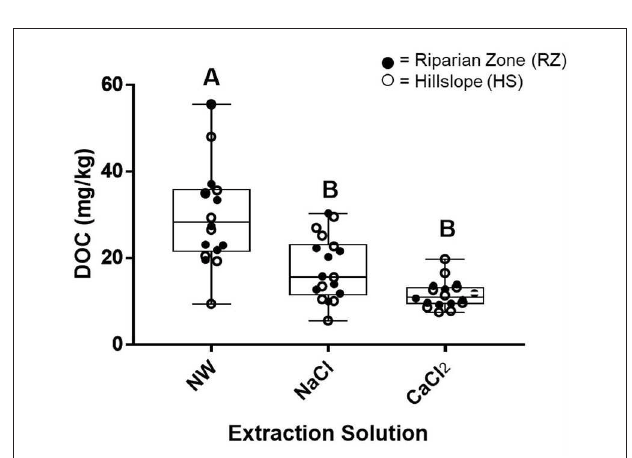
FIGURE 9 | Boxplots showing the mean and range of DOC concentrations (mg/kg) determined by treatment with three aqueous soil extraction solutions (NW, Nanopure Water; sodium chloride (NaCl), and calcium chloride (CaCl 2 ). Treatments ( n = 18) with different letters indicate pairs of means that are significantly different ( p <